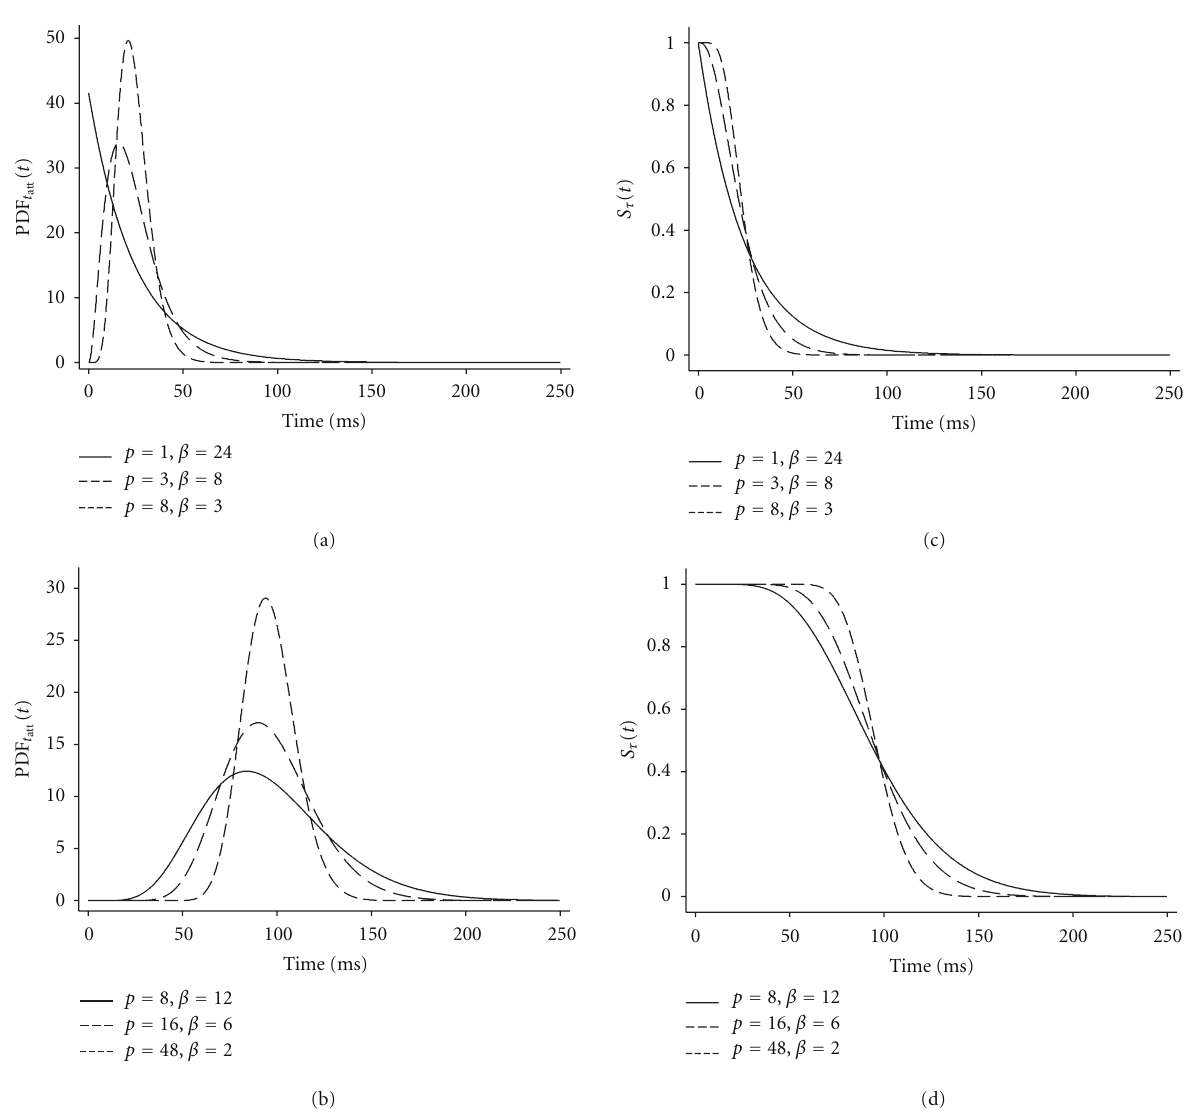
Figure 2: Examples of gamma distributions and associated survival functions. (a, b) The two parameters of the gamma distribution ( p and β ) permit description of a wide variety of distributions useful for representing the probability density function for myosin crossbridge ( t ). Notably, a single exponential results when p = 1 (a), and a Gaussian distribution is approximated as p increases. attachment time, PDF t att (c, d) The survival function, S τ ( t ), refers to the probability that an attached crossbridge will survive to time t . The analytical relationship ( t ) and S τ ( t ) is provided by (10a) and between the PDF t att